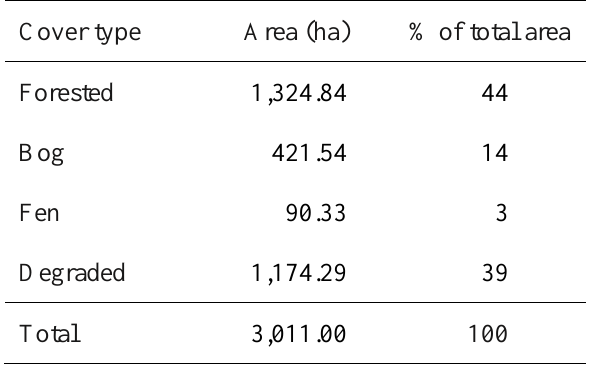
Table 1. Extent of different land cover types on the current total area of peatlands in Terceira Island. Based on Mendes et al .